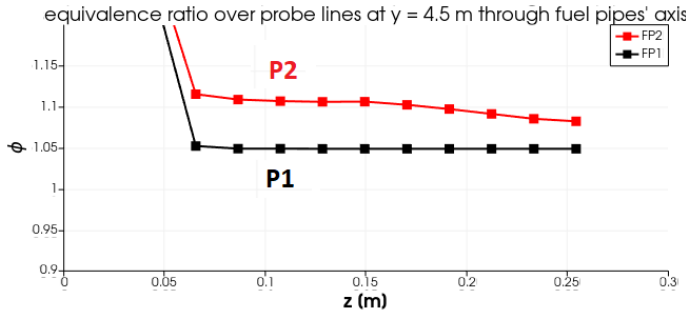
Figure 7. Computed equivalence ratio φ on two probe lines at y = 4.5m after t = 62s of simulation time.